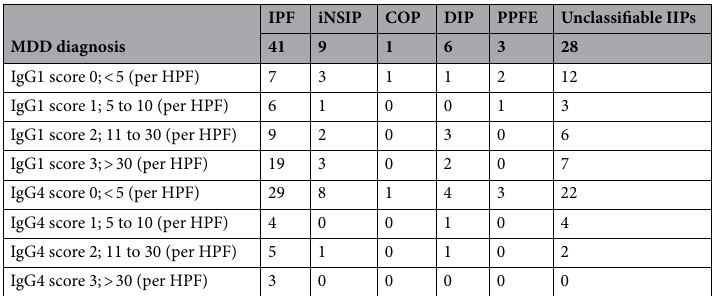
Table 1. IgG1- and IgG4-positive cells in the lungs with IIPs. Data are presented as N. We defined interstitial pneumonia when IgG1-positive cell infiltration was > 30/HPF and IgG4-positive cell infiltration was > 10/HPF. COP cryptogenic organising pneumonia, DIP desquamative interstitial pneumonia, HPF high-power field, Ig immunoglobulin, IIP idiopathic interstitial pneumonia, iNSIP idiopathic non-specific interstitial pneumonia, IPF idiopathic pulmonary fibrosis, MDD multidisciplinary discussion, PPFE pleuroparenchymal